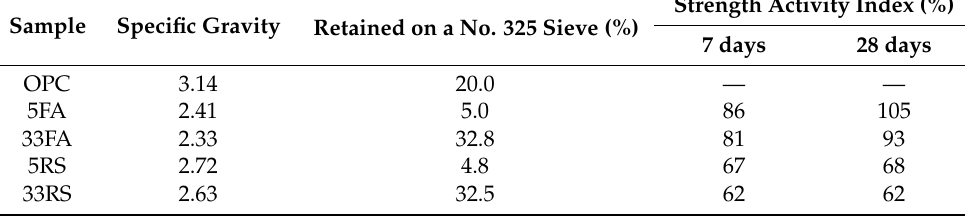
Table 2. Physical properties of materials.